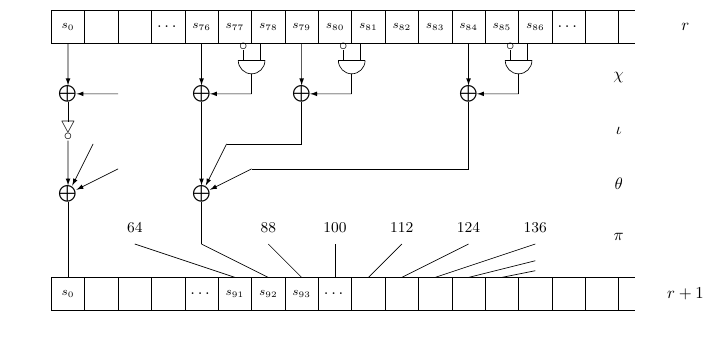
Figure 3: Subterranean round